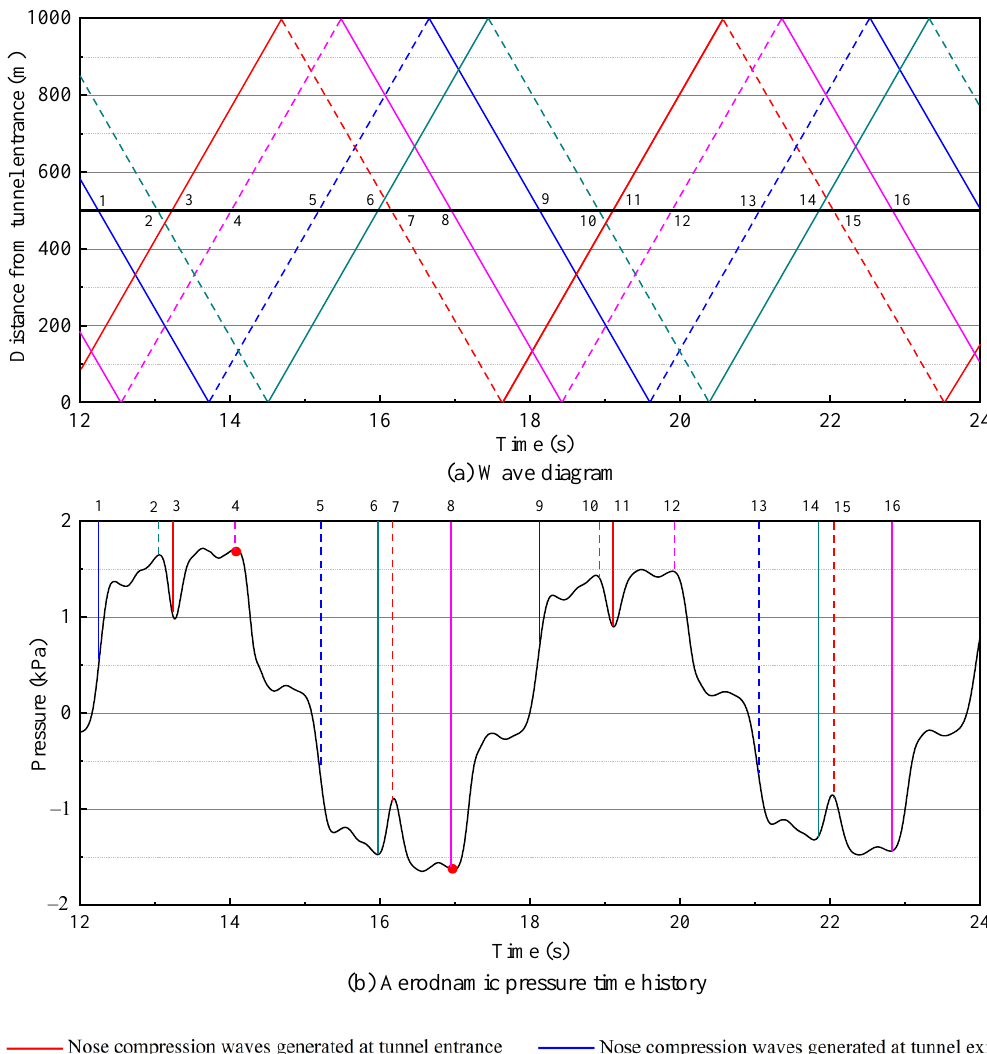
Figure 22. Wave diagram and aerodynamic pressure time history of monitoring point 10-V in Stage III at train speed of 375 km/h.